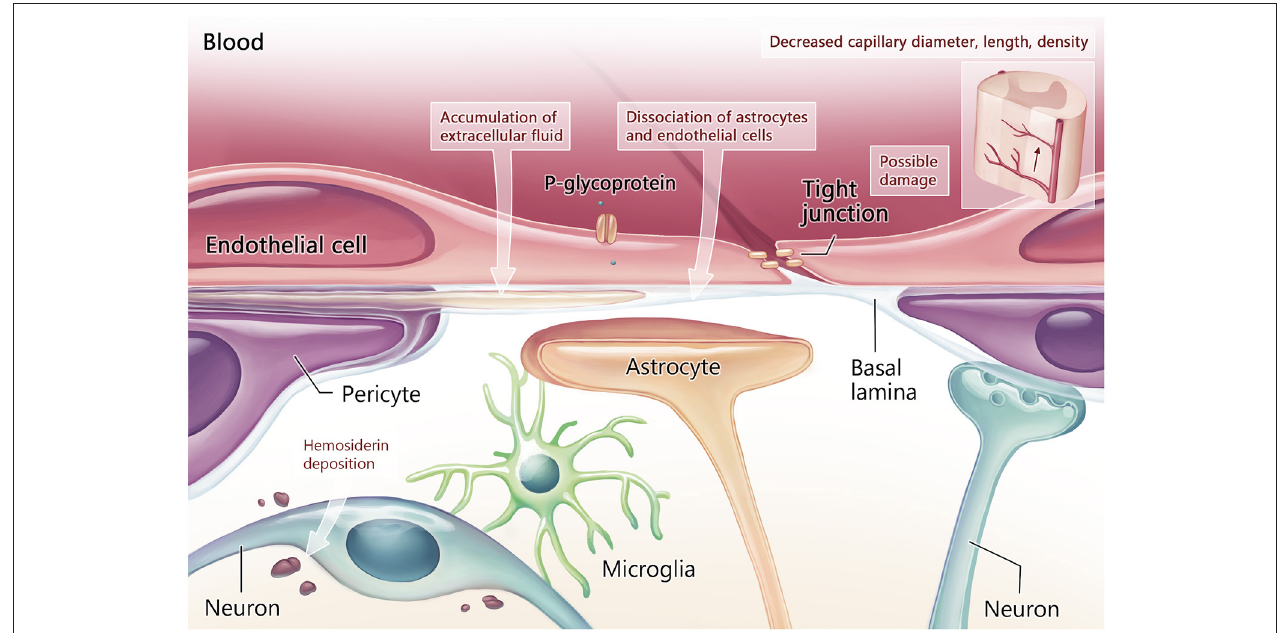
FIGURE 1 | Blood-CNS barrier structure and function in the early stage of ALS. Early in the disease process, damage to tight junctions is associated with vascular pathology including reduction in capillary diameter, length, and density. Other structural damage includes dissociation of the astrocytes and endothelial cells of the neurovascular unit, which have been noted prior to motor neuron degeneration. Loss of neurovascular unit integrity leads to accumulation of extracellular fluid and hemosiderin deposition around motor